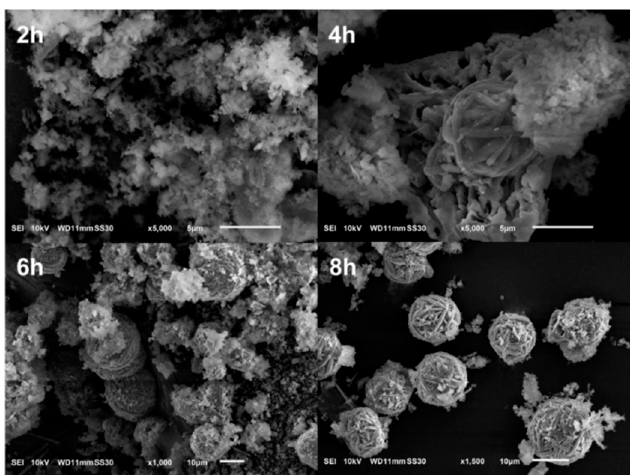
Figure 2. SEM images of diatomite-based material (DBM) after hydrothermal treatment for 2, 4, 6, and 8 h.